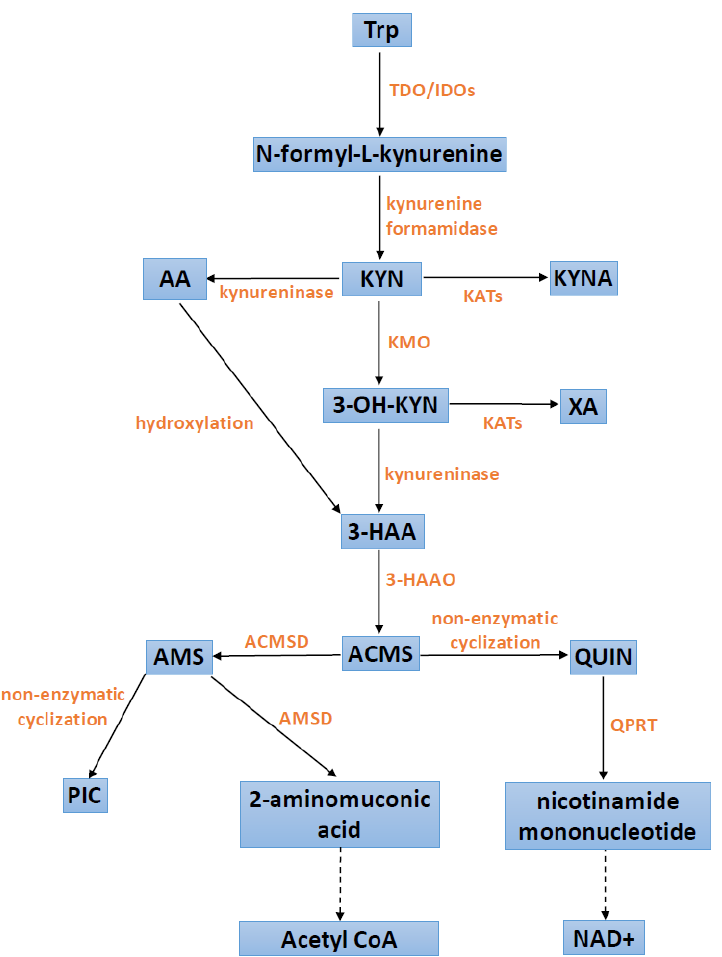
Figure 1. Scheme of the kynurenine pathway. 3-HAA: 3-hydroxyanthranilic acid; 3-HAAO: 3-hydroxyanthranilic acid 3,4-dioxygenase; 3-OH-KYN: 3-hydroxykynurenine; AA: anthranilic acid; acetyl CoA: acetyl coenzyme A; ACMS: 2-amino-3-carboxymuconicacid-6-semialdehyde; ACMSD: 2- amino-3-carboxymuconic acid semialdehyde decarboxylase; AMS: 2-aminomuconic-6-semialdehyde; AMSD: 2-aminomuconic semialdehyde dehydrogenase; IDOs: indoleamine 2,3-dioxygenases; KATs: kynurenine aminotransferases; KMO: kynurenine-3-monooxygenase; KYN: kynurenine; KYNA: kynurenic acid; NAD + : nicotinamide adenine dinucleotide; PIC: picolinic acid; QPRT: quinolonate phosphoribosyl transferase; QUIN: quinolinic acid; TDO: tryptophan 2,3-dioxygenase; Trp: trypto- phan; XA: xanthurenic